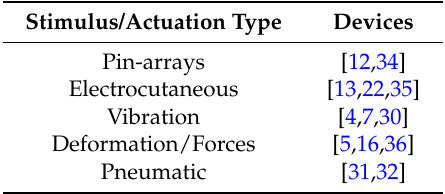
Table 1. Wearable haptic systems (WHS) main actuation types.